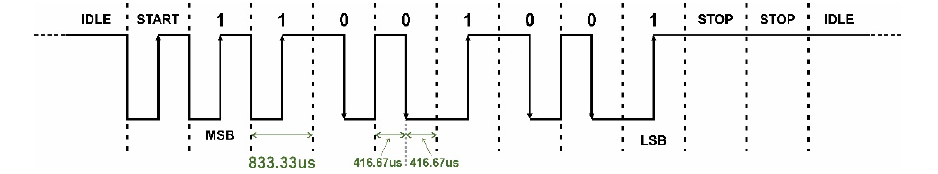
Figure 2. Manchester encoding.